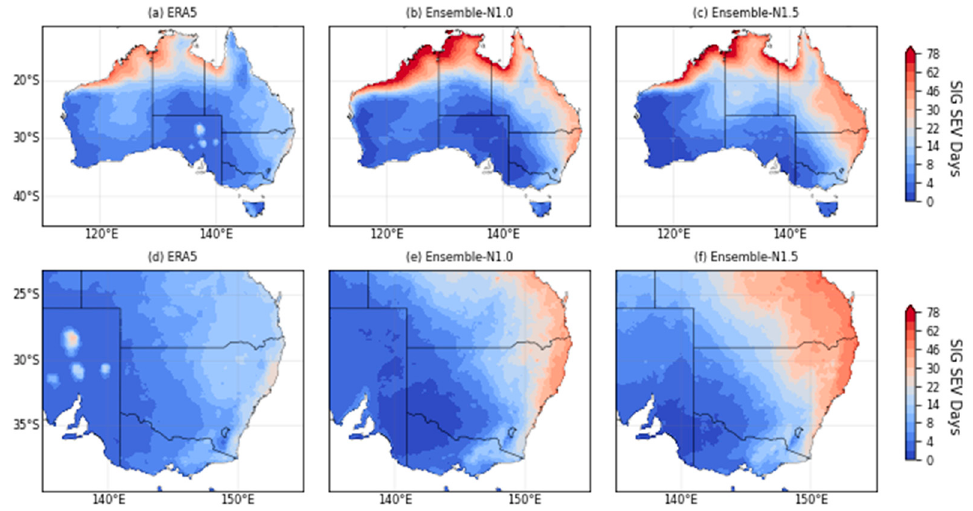
Figure 13. As in Figure 12 except for TSTORM exceeding the significant severe thunderstorm threshold of 68,000 J kg − 1 m s − 1 .